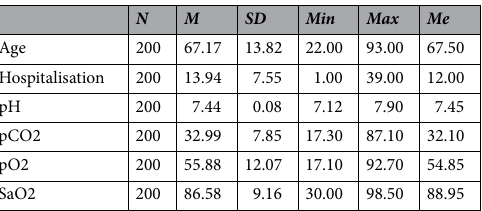
Table 2. Descriptive statistics of the studied group. N —number; M —mean; SD —standard deviation; Min — minimum; Max —maximum; Me —median.